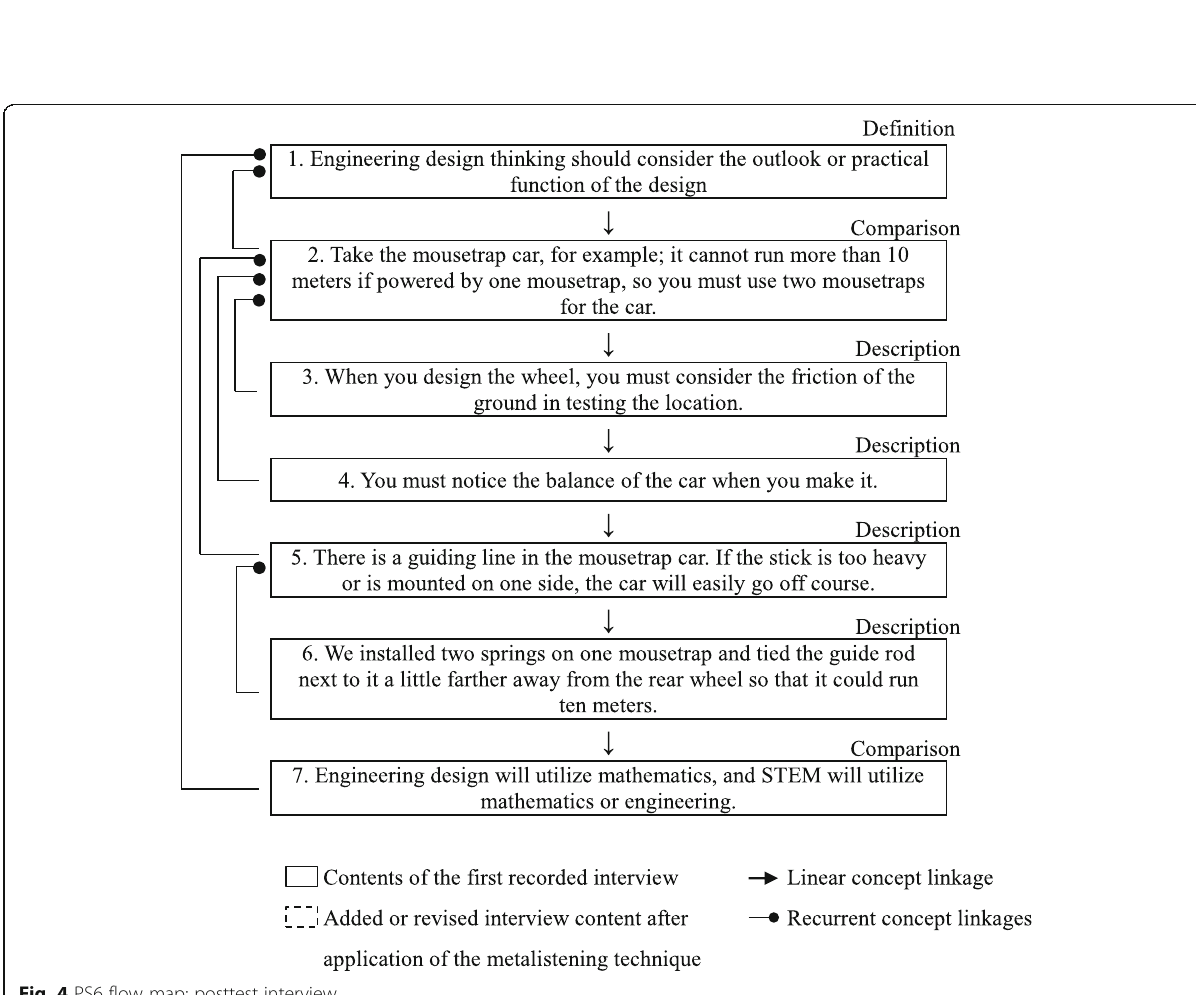
Fig. 4 PS6 flow map: posttest